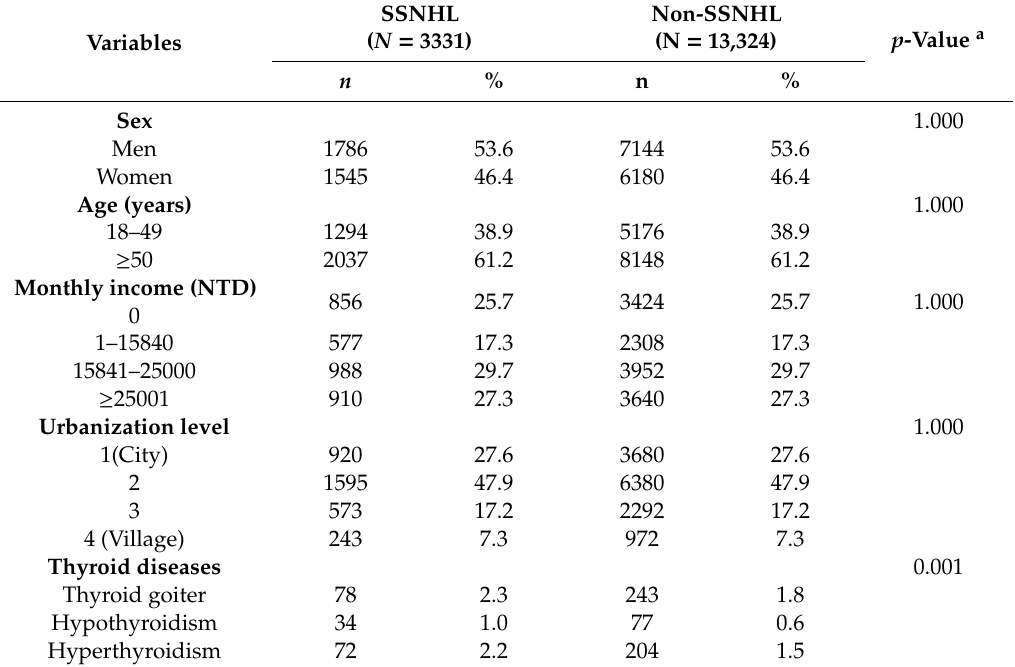
Table 1. Demographic Characteristics of Sensorineural Hearing Loss and Control